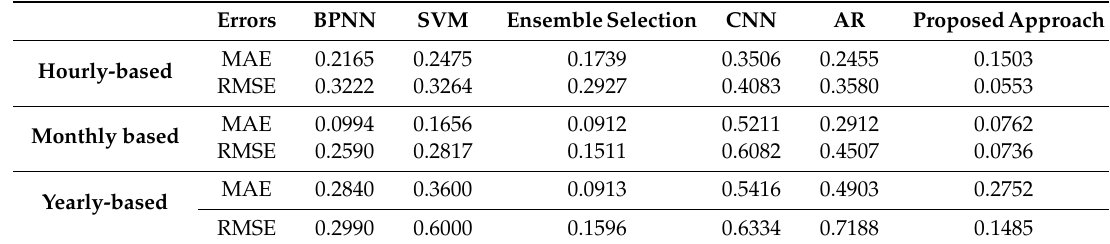
Table 3. Comparison of the mean absolute error (MAE) and root mean square error (RMSE) of the proposed approach with other methods for hourly, monthly and yearly wind turbine